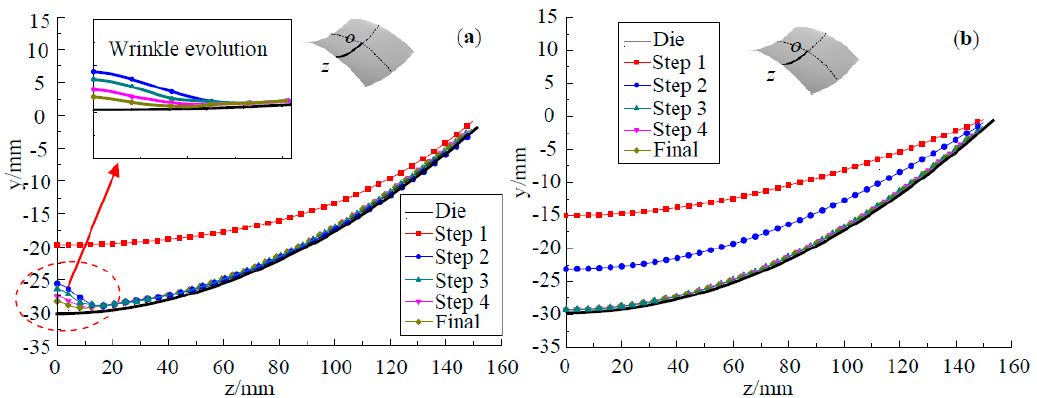
Figure 12. Transverse section lines of the saddle-shaped part in di ff erent steps. ( a ) C-SF; ( b ) UC-SF.